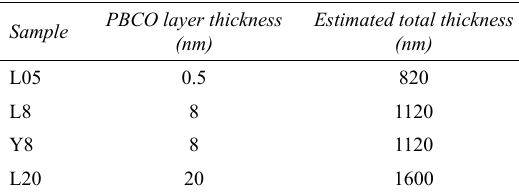
Table 1: Notation and description of the samples.